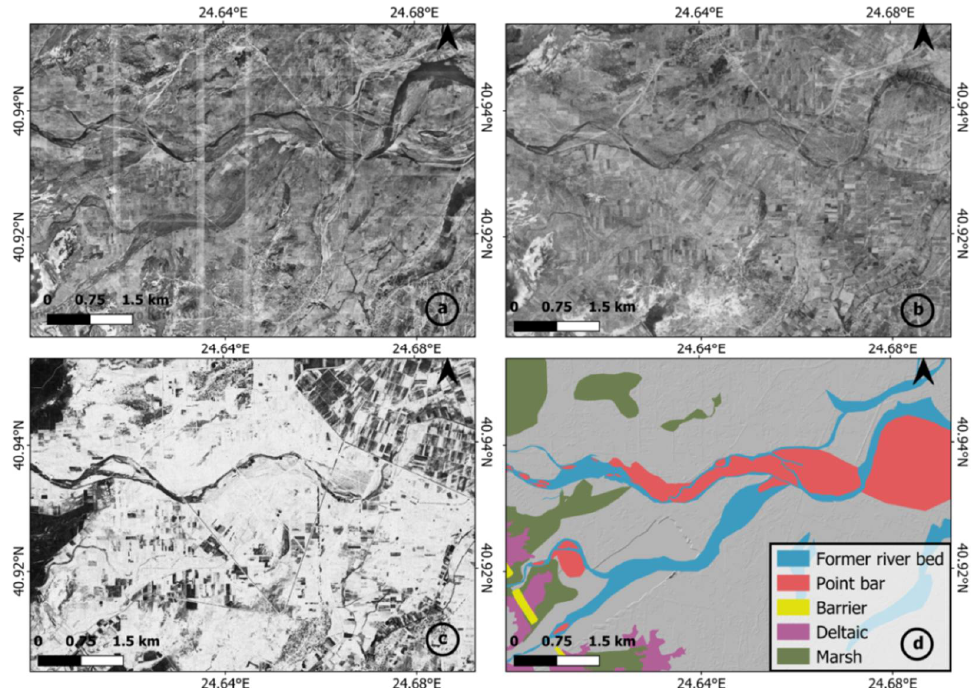
Figure 5. Recent evolution of meandering streams and progression of irrigation and drainage modifications according to ( a ) the orthophoto map from 1945 derived from Hellenic Cadastre, ( b ) KH-4 image from 1960 and ( c ) KH-4 image from 1968, ( d ) mapped geomorphological fluvial and deltaic formations.